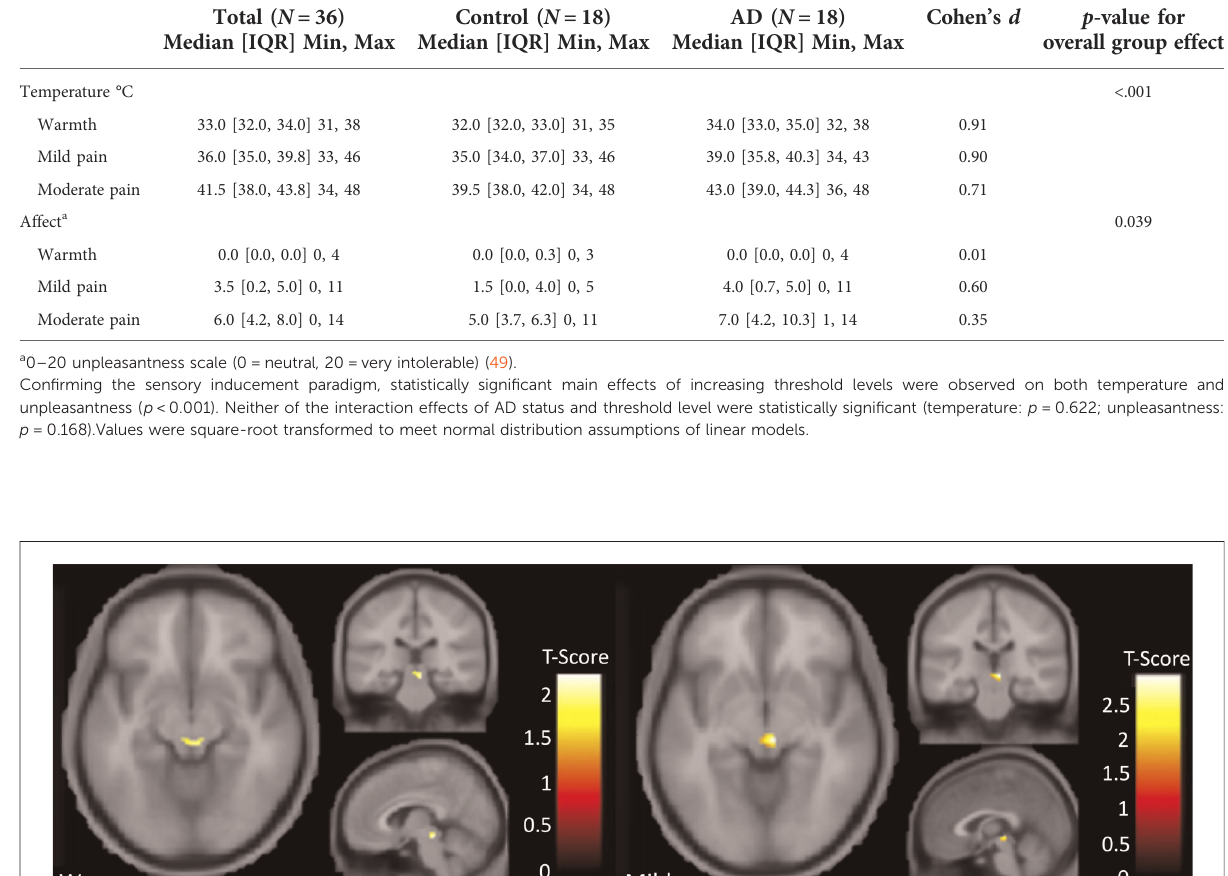
TABLE 2 Psychophysics of temperature thresholds necessary to produce percepts of warmth, mild pain, and moderate pain, as well as unpleasantness ratings (pain affect) at each percept level by study group.